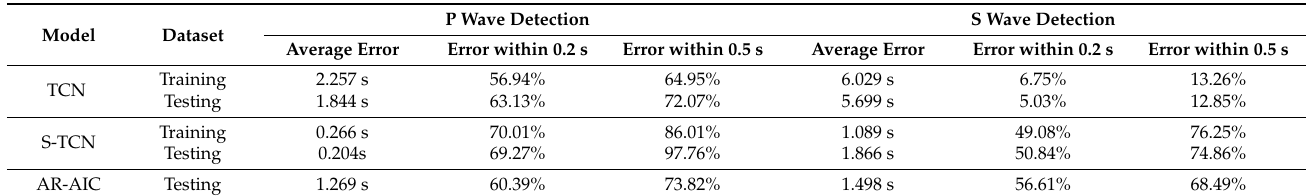
Table 2. A comparison of errors in the detection of P and S waves between the TCN and the SELD-TCN models.